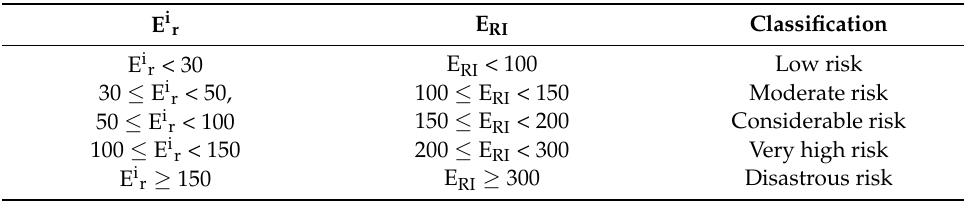
Table 2. Classification of ecological risk index (E RI ) of heavy metal pollution [55,56]. E i r